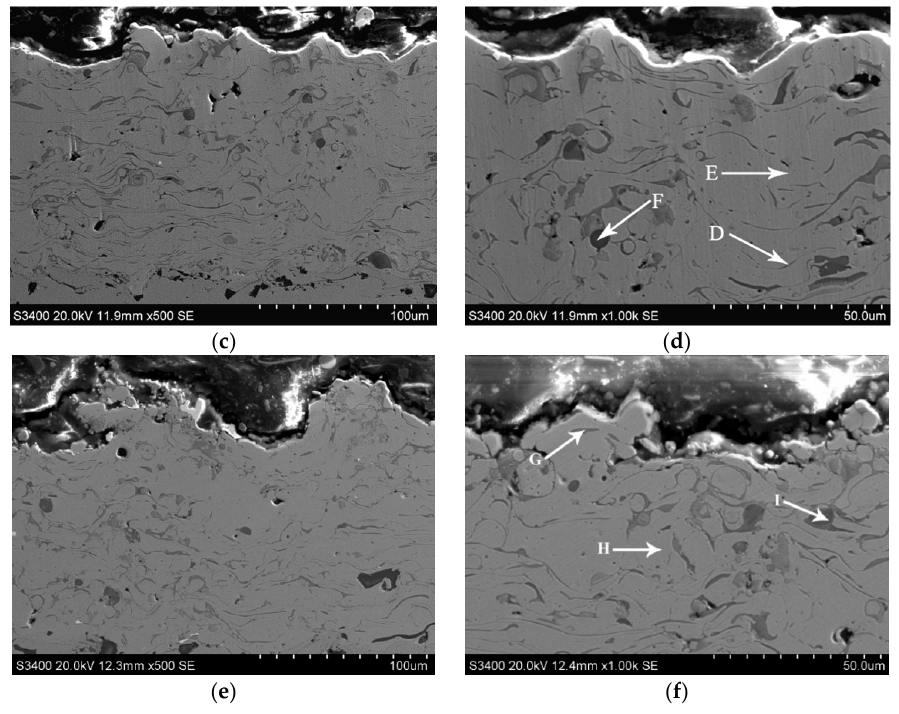
Figure 4. Microstructure of the coatings: ( a ) 5TiB 2 –5ZrB 2 –NiCr; ( b ) higher magnification image of 5TiB 2 –5ZrB 2 –NiCr; ( c ) 10TiB 2 –10ZrB 2 –NiCr; ( d ) higher magnification image of 10TiB 2 –10ZrB 2 –NiCr; ( e ) 15TiB 2 –15ZrB 2 –NiCr; and ( f ) higher magnification image of 15TiB 2 –15ZrB 2 –NiCr. Table 3. Chemical composition (at.%) in different regions in Figure 4.